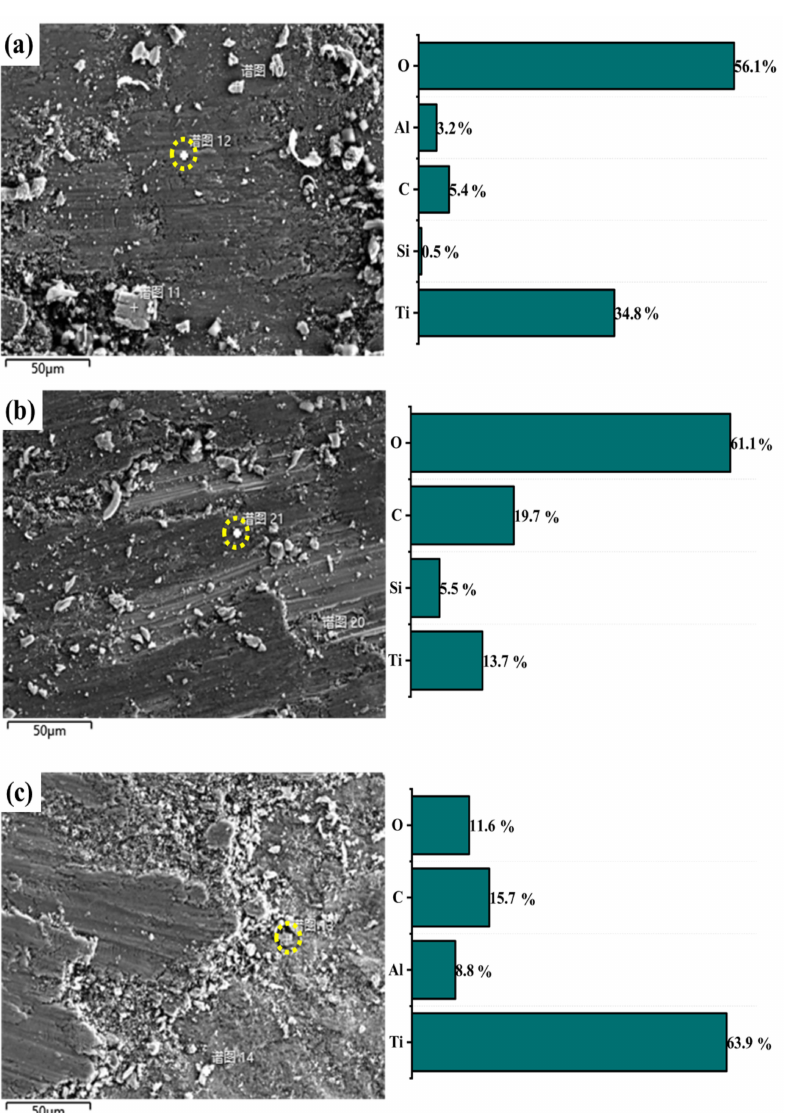
Figure 9. EDS results of worn surface with different particles: ( a ) MAO, ( b ) Ti 2 SiC 3 , ( c ) Ti 2 AlC 3